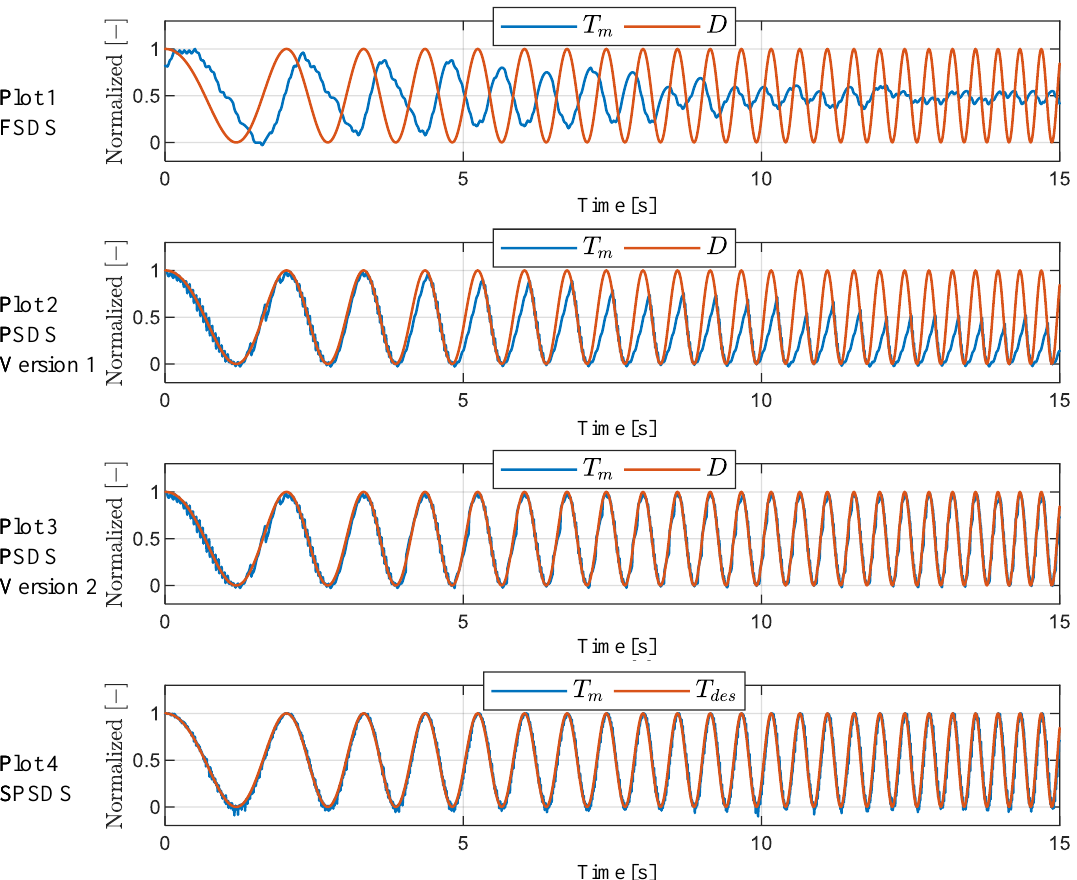
Figure 26. DDM torque response with a sinusoidal input signal operating at 50